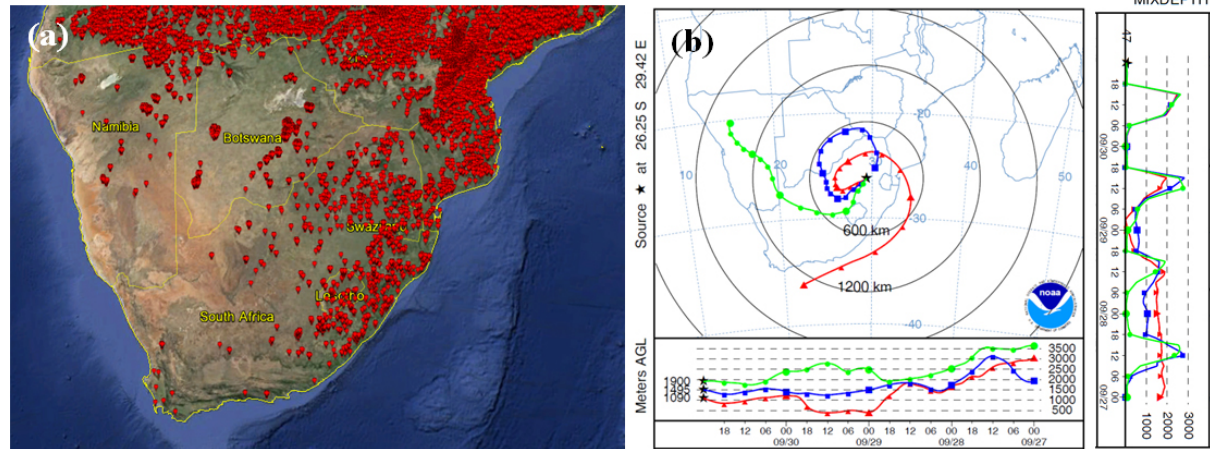
Figure 3. MODIS fire hotspots for the period 28 September 2010–1 October 2010 and for the latitude range between − 35 and − 15 ◦ W and the longitude range between 10 and 40 ◦ S (a) . Four-day backward trajectories arriving at Elandsfontein on 1 October 2010 at 00:00UTC for arrival height of the bottom (1090m), centre (1495m) and top (1900m) of the aerosol layer observed (b) .